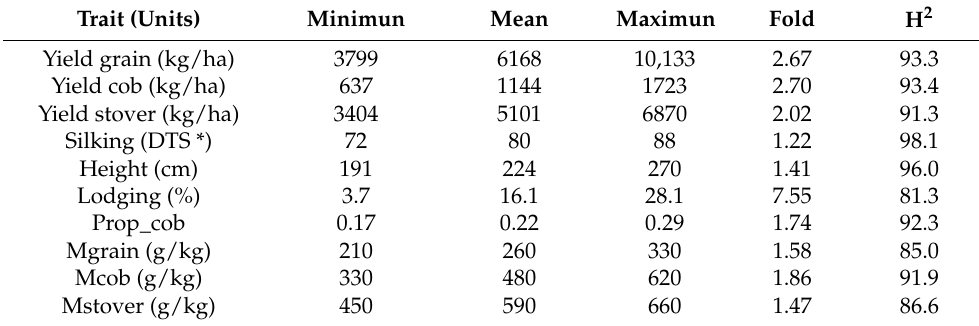
Table 2. Summary of agronomic traits with units plus minimum, mean, and maximum BLUP values; fold difference between minimum; and broad sense heritability (H 2 ) for ten agronomic traits—yield grain, yield cob, yield stover, silking, height, lodging, proportion of cob (Prop cob), moisture of the grain (Mgrain), cob moisture (Mcob), and stover moisture (Mstover) estimated from 20 maize genotypes grown at four environments in Pontevedra, Spain, in 2010 and